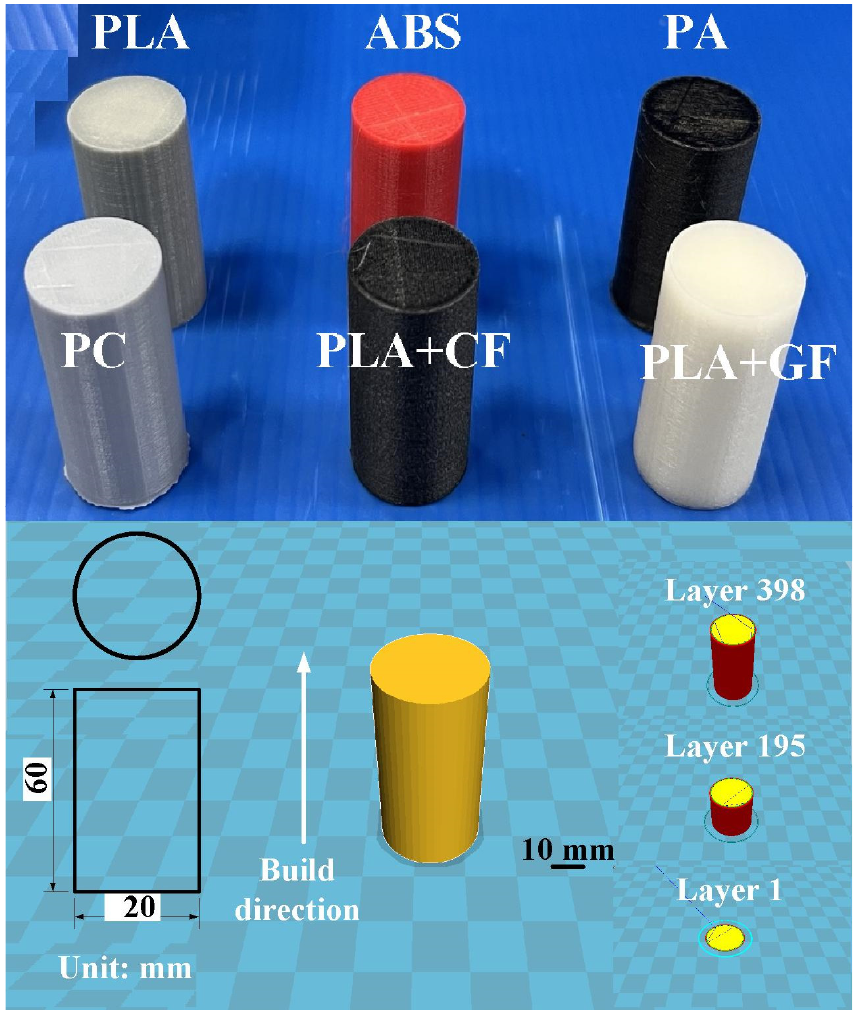
Figure 2. CAD model and dimensions of FW specimens. Polymer FW is a solid-state joining process, which provides axial movement to obtain the required weld strength. During FW, axial pressure is used for the consolidation of the weld. One polymer rod was rotated at a constant speed while the other was kept stationary. Two polymer rods were brought together under pressure for a certain period of time. Table 1 shows the experimental conditions of FW. In this study, the cycle time of FW was set to 60 s according to previous work [31]. The cycle time involves a friction time of 30 s, a forge time of 20 s, and a cooling time of 10 s. The burn-off length was set to 2 mm since the FW was carried out 20 times with a weld length of 0.1 mm each time. To investigate the effects of the rotational speed on the joint strength of friction-welded dissimilar polymer rods fabricated by three-dimensional printing, five different rotational speeds, i.e., 330 rpm, 490 rpm, 650 rpm, 950 rpm, and 1350 rpm were employed in this study. Figure 3 shows the situation of FW and a schematic illustration of the FRW process. A conventional lathe was used to perform FW. One cylindrical rod is kept stationary while the other is rotated at a constant speed. In this study, a fixture is designed and implemented to clamp one cylindrical rod to prevent one rod from simultaneously rotating with the rotating cylindrical rod. In general, the heat generated by friction in the weld joint during FW emits infrared energy [32]. The peak temperature of the weld bead during FW was monitored and recorded using an infrared camera (BI-TM-F01P, Panrico trading Inc., New Taipei City,